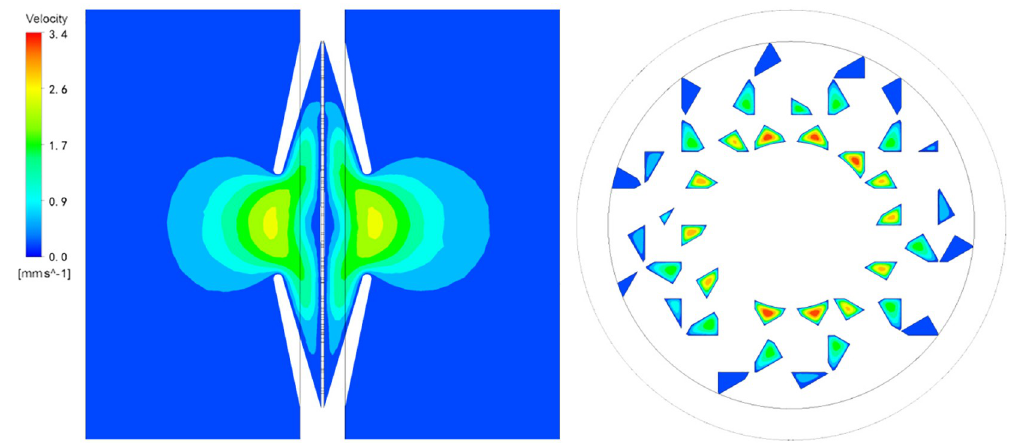
Fig 8. Velocity distribution of fluid in the torus-margo bordered